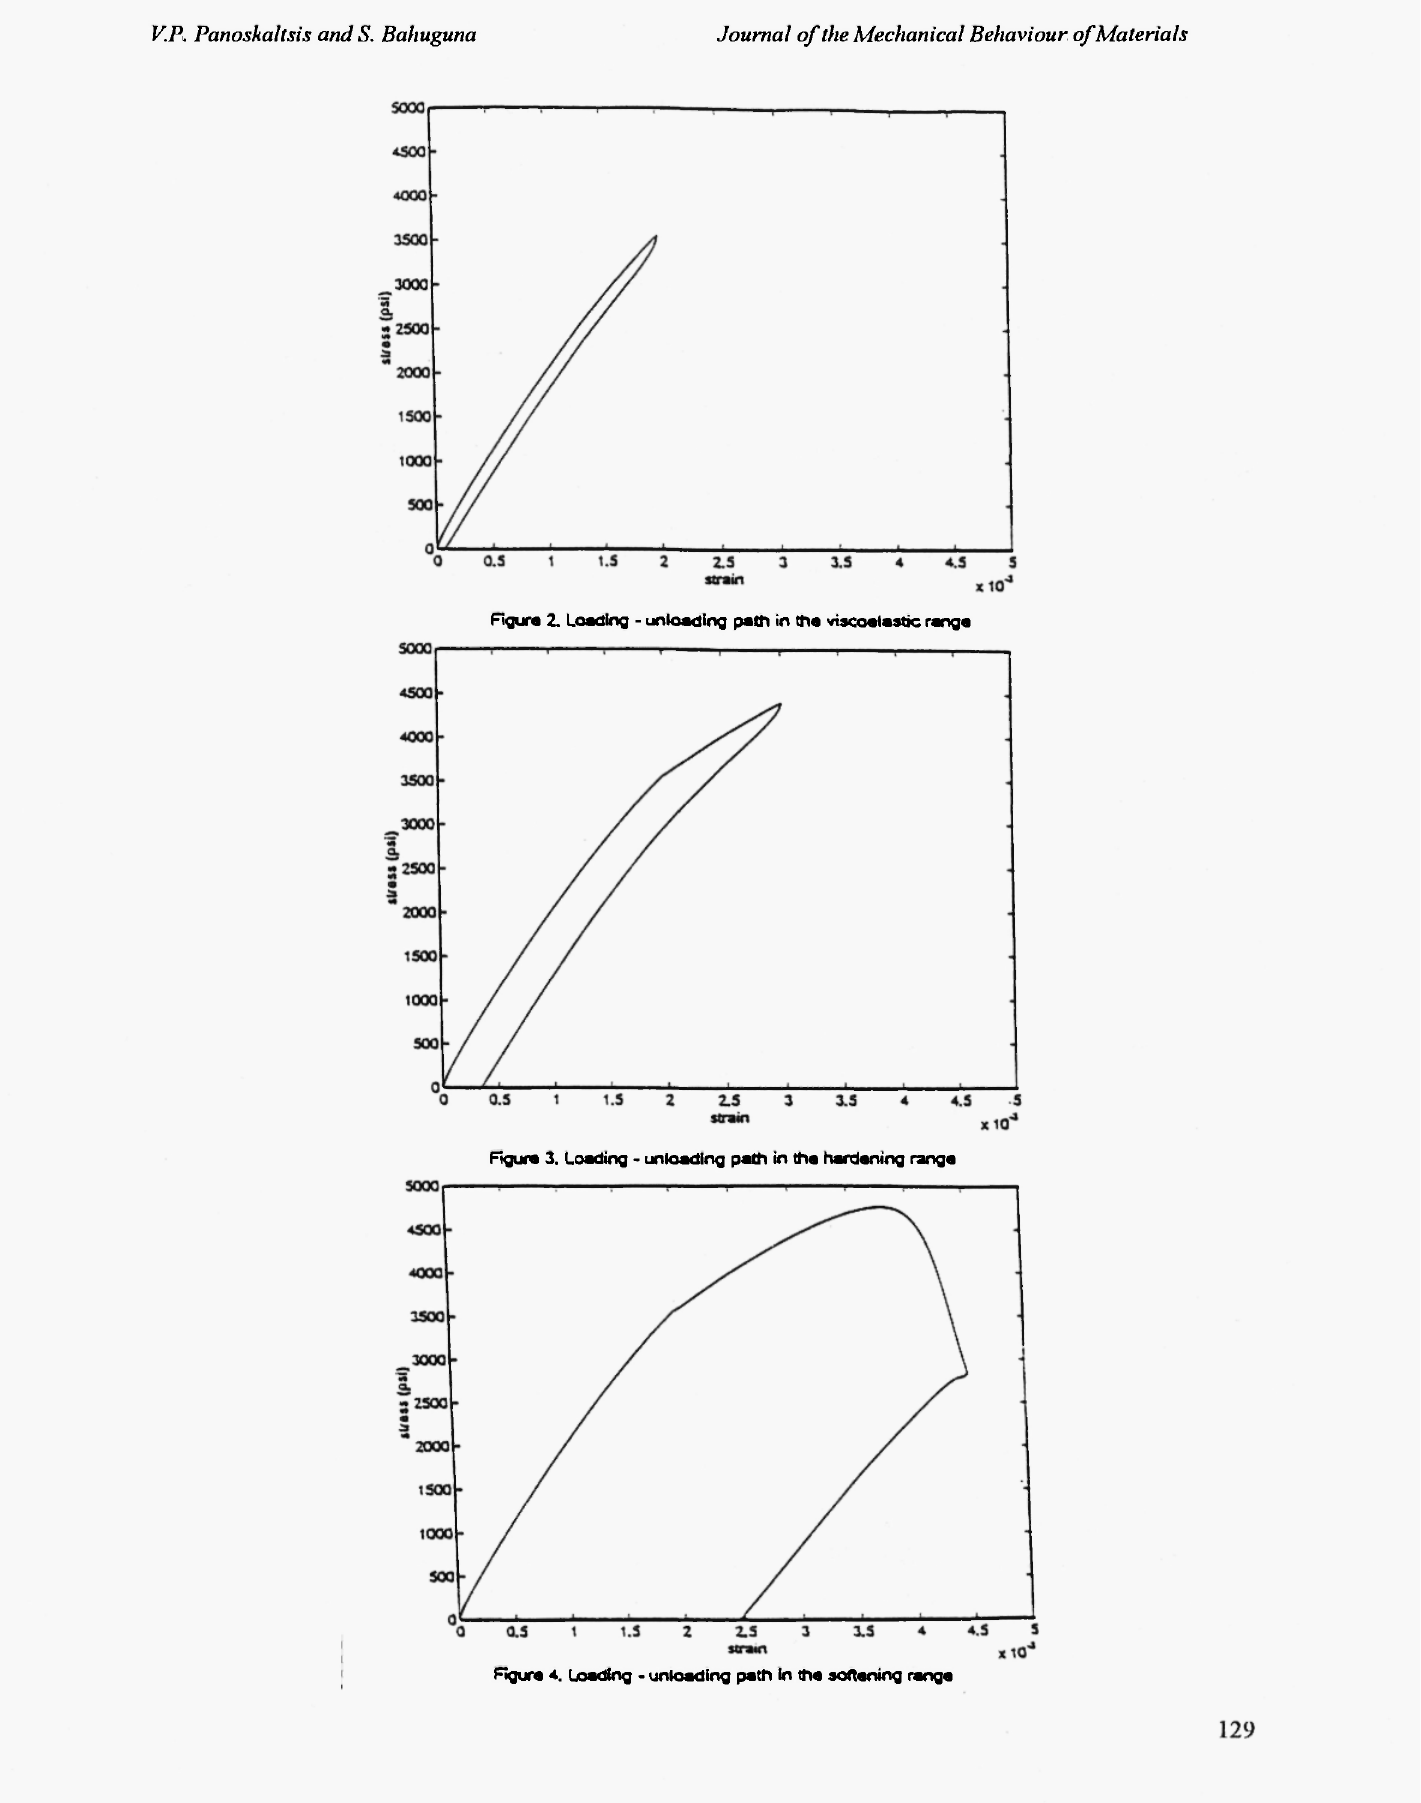
Figure 2. Loading - unloading path in the viscoetastic range